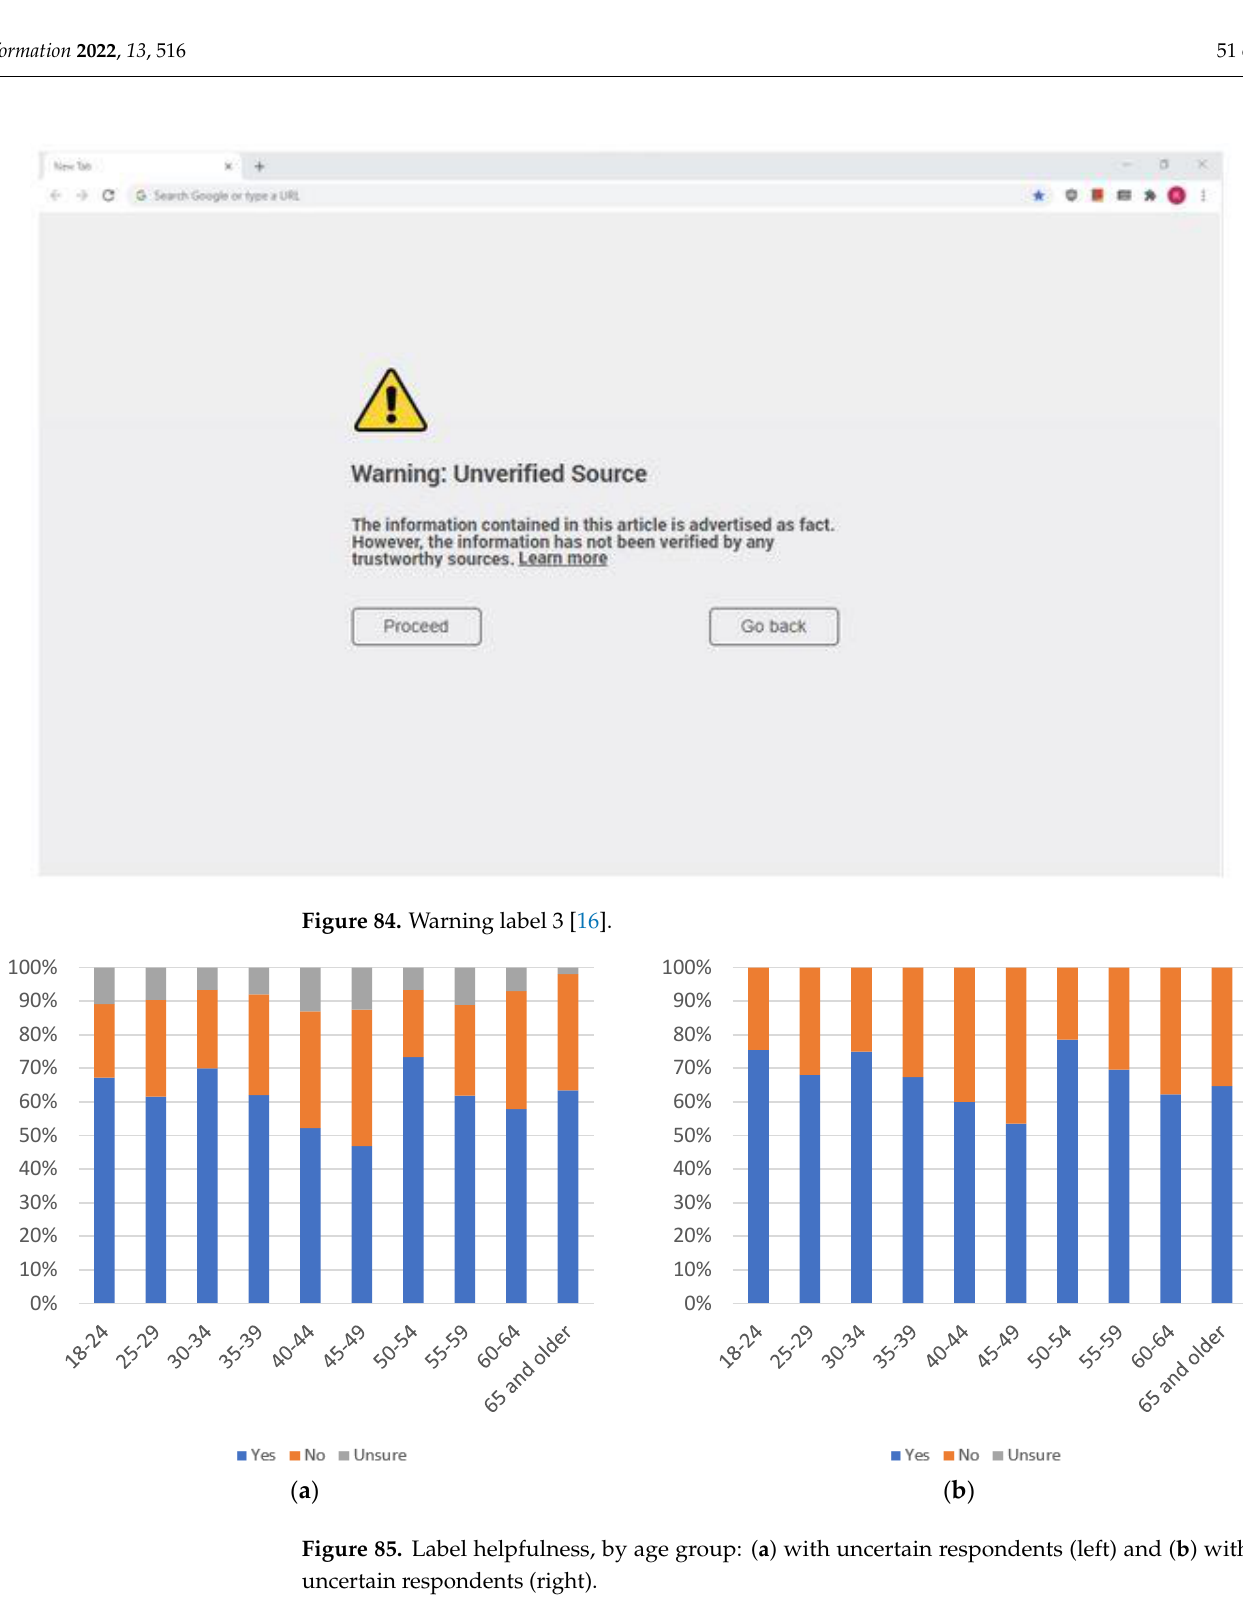
( b ) Figure 86. Label helpfulness, by education level: ( a ) with uncertain respondents (left) and ( b ) with- out uncertain respondents (right).